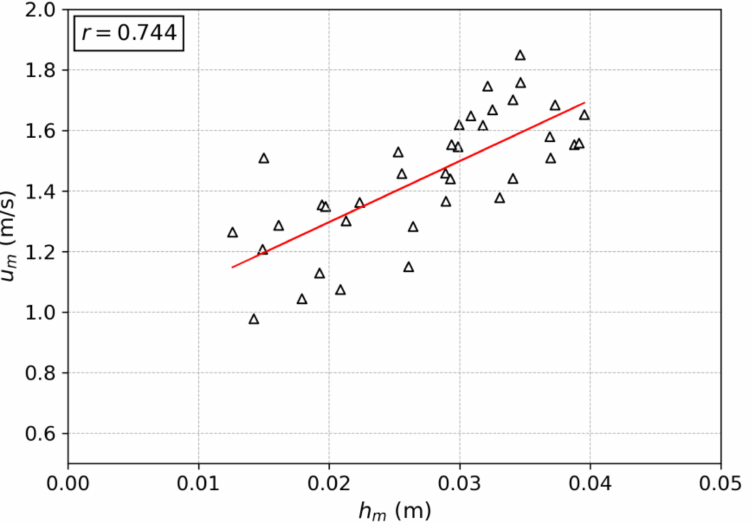
Figure 14. Comparison of the measured OFV and OLT at the rear edge breakwater crest corresponding to the same wave overtopping